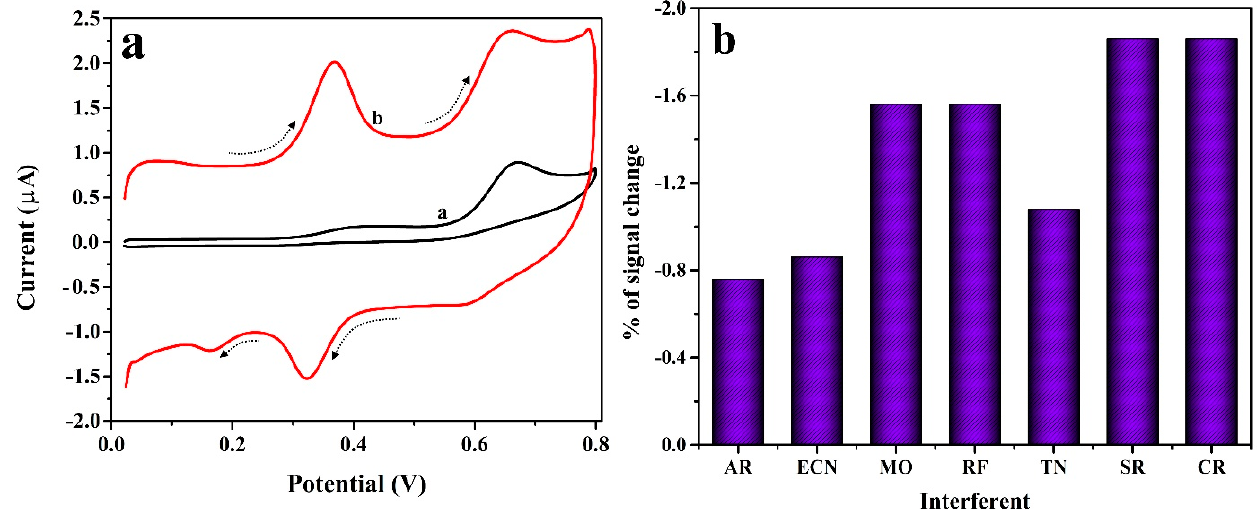
Figure 8. ( a ) Cyclic voltammograms for 0.01 mM ICN in presence of 0.1 mM TN at the surface of BCNTPE (curve-a) and P(PAN)LCNTPE (curve-b) in PB (0.2 M & 6.5 pH) at 0.1 Vs − 1 scan rate. ( b ) % error in signal vs. interferents.